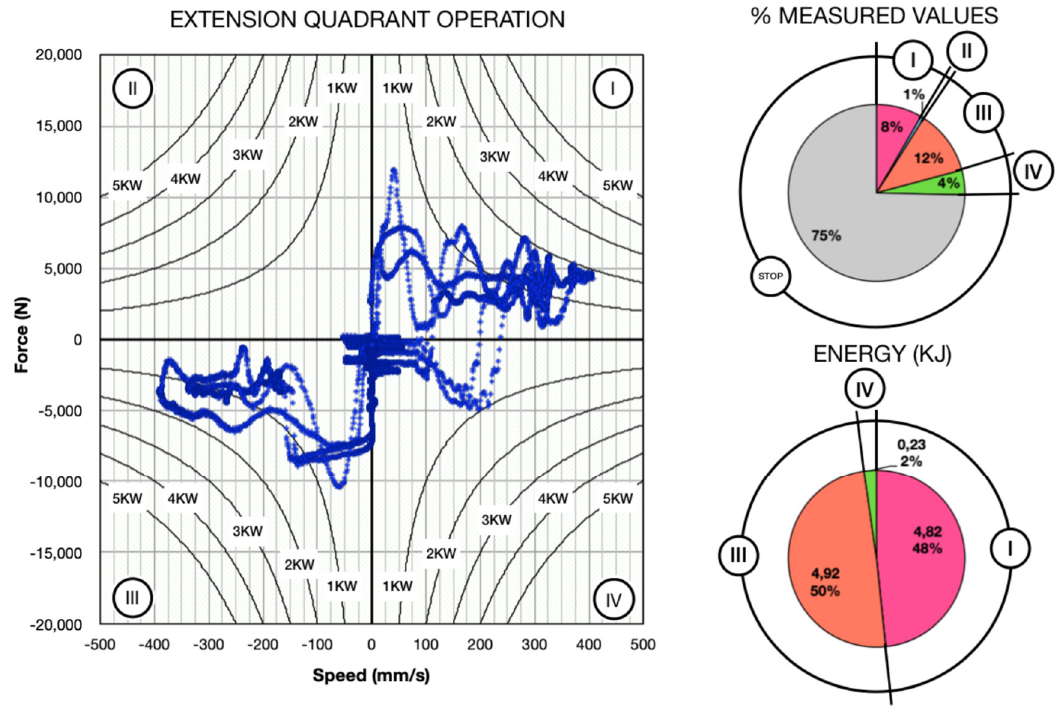
Figure 14. Quadrant operation of the extension actuator.